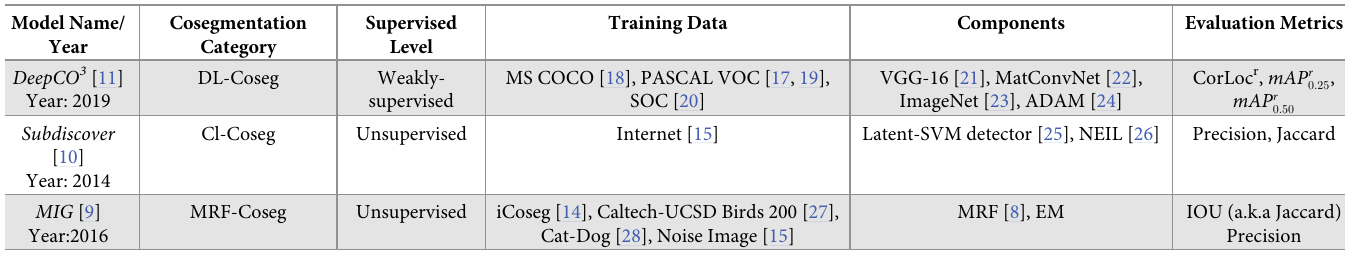
Table 2. A condensed review of the three cosegmentation